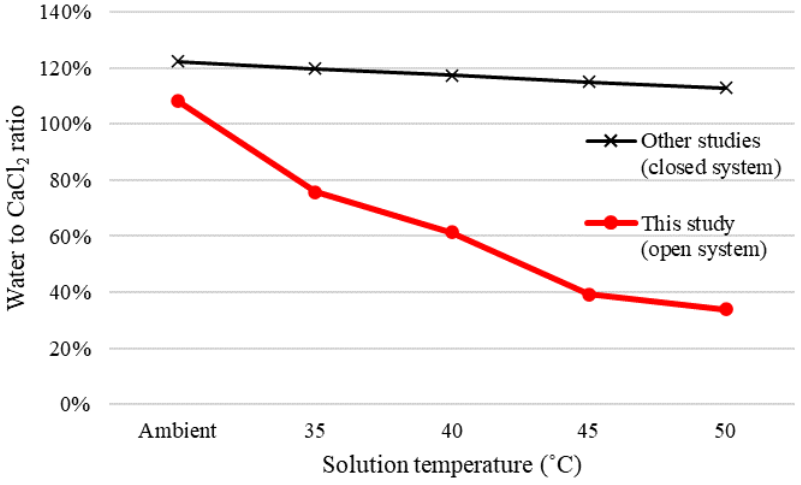
Figure 8. Comparison of the average water content when the solution temperature is the same as ambient temperature (25 ± 2 °C) [30,31], and when they are different (this study).